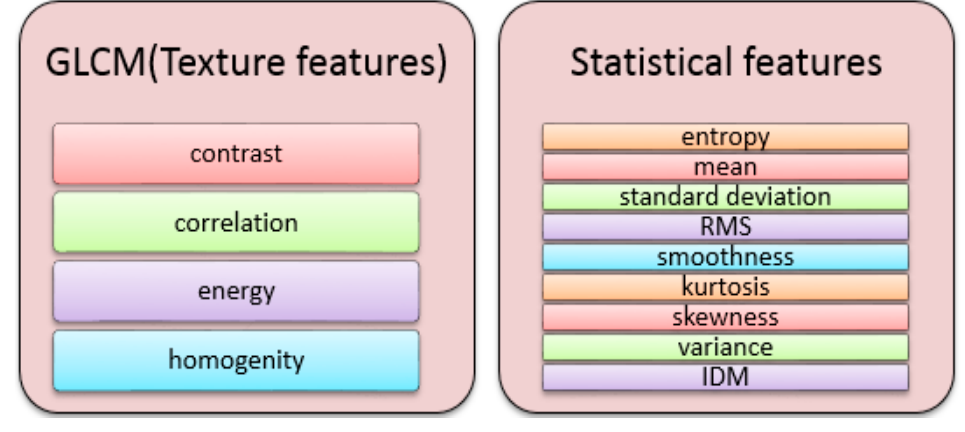
Figure 5. Features